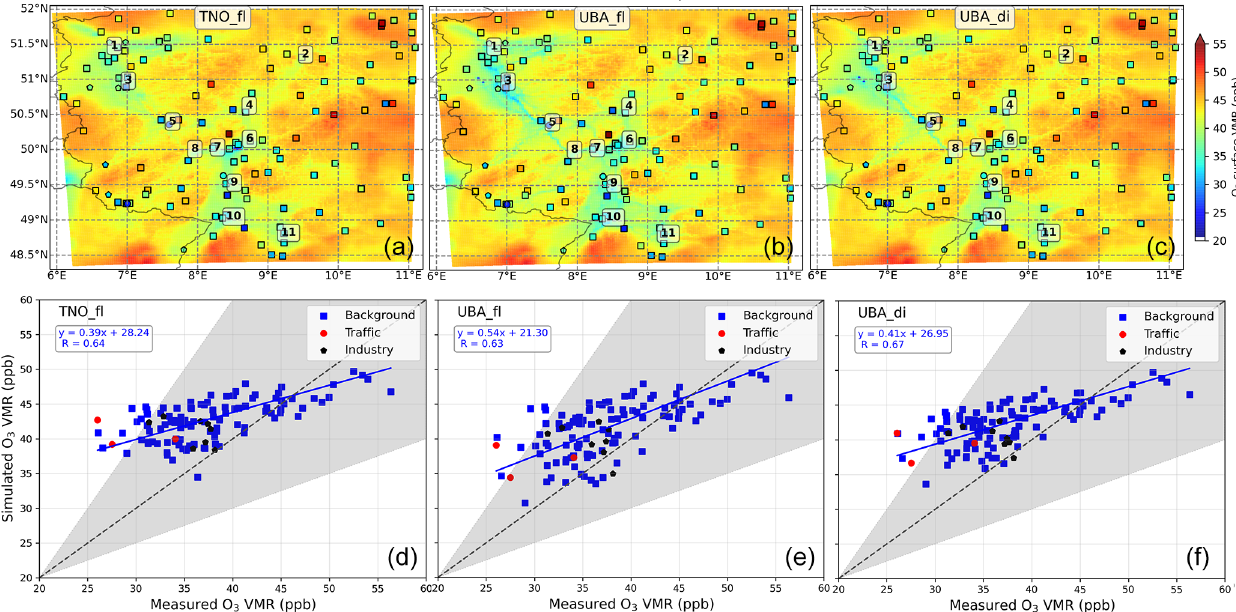
Figure B1. Spatial distribution of monthly-mean O 3 surface VMRs for the three simulations using different emission inventories ( a, d : TNO, b, e : UBA without diurnal variations, c, f : UBA with diurnal variations) for May 2018. Panels (d) , (e) and (f) show the scatter plot and orthogonal distance regression (ODR) weighted by the inverse of the square of the standard deviation of simulated monthly-mean O 3 surface VMRs with respect to the in situ measured values. ODR was performed only for the background stations because of the low number of stations at the traffic-adjacent and industrial locations.